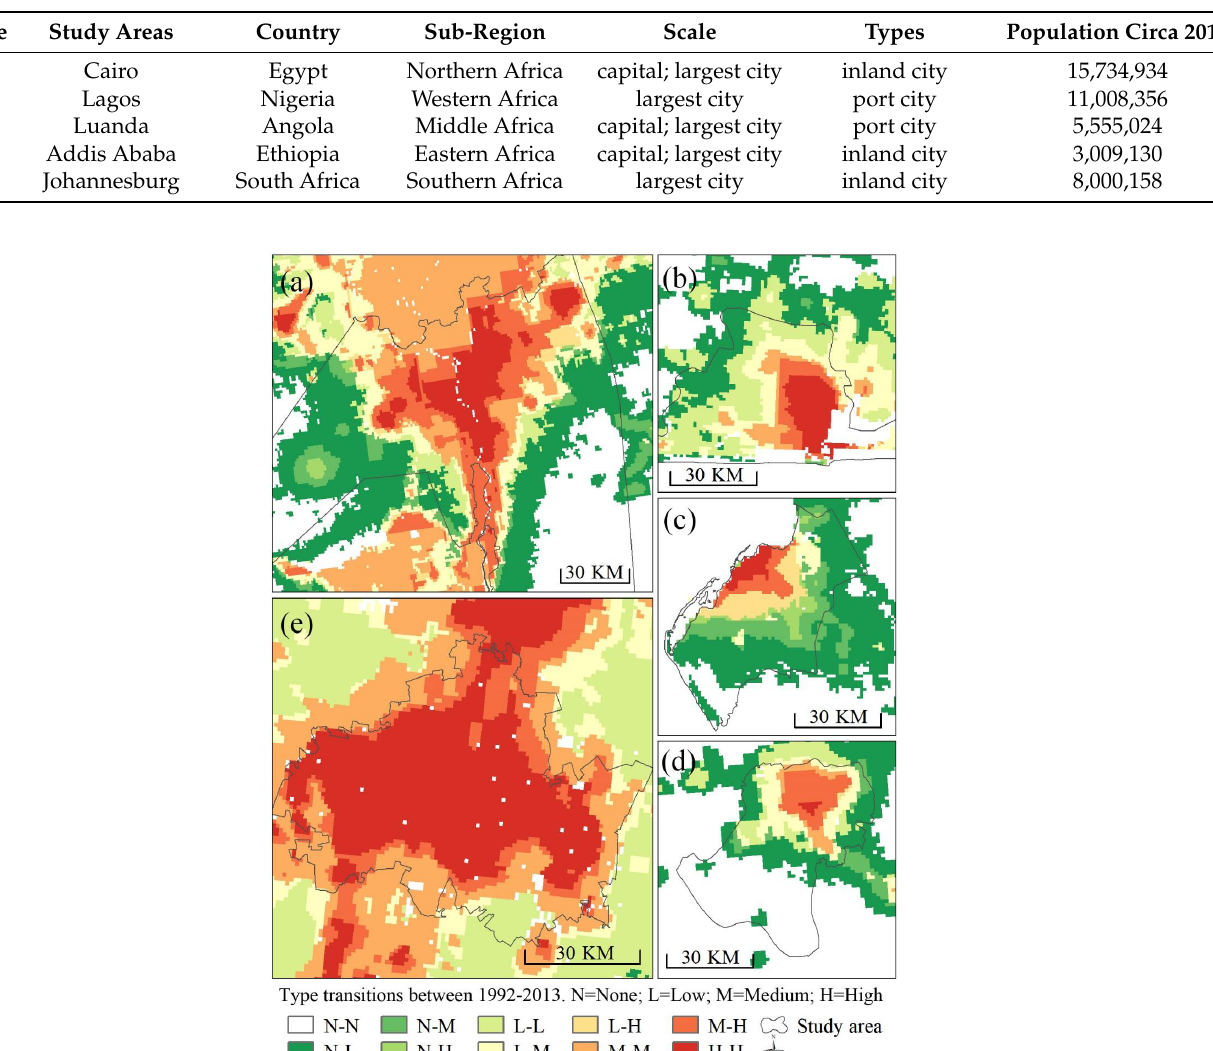
Table 5. Detailed information of the cities presented in Figure 9.